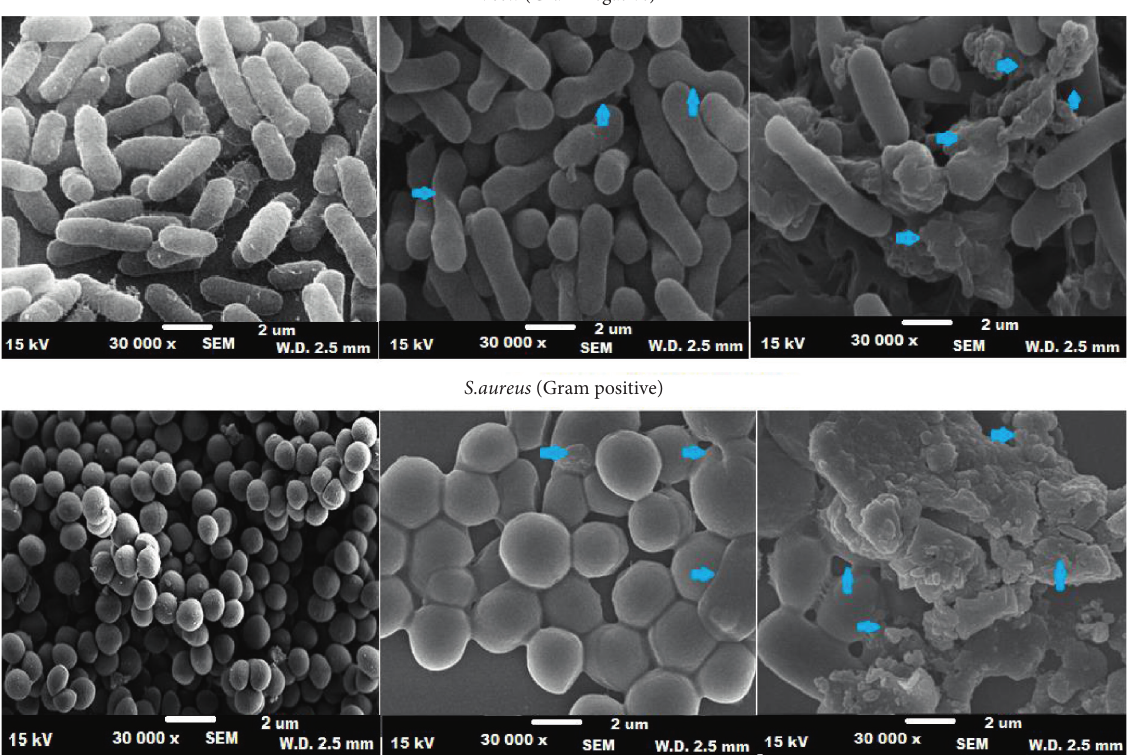
Figure 9: SEM images of untreated and treated with the polymeric bionanocomposite and altered shape of E. coli and S. aureus